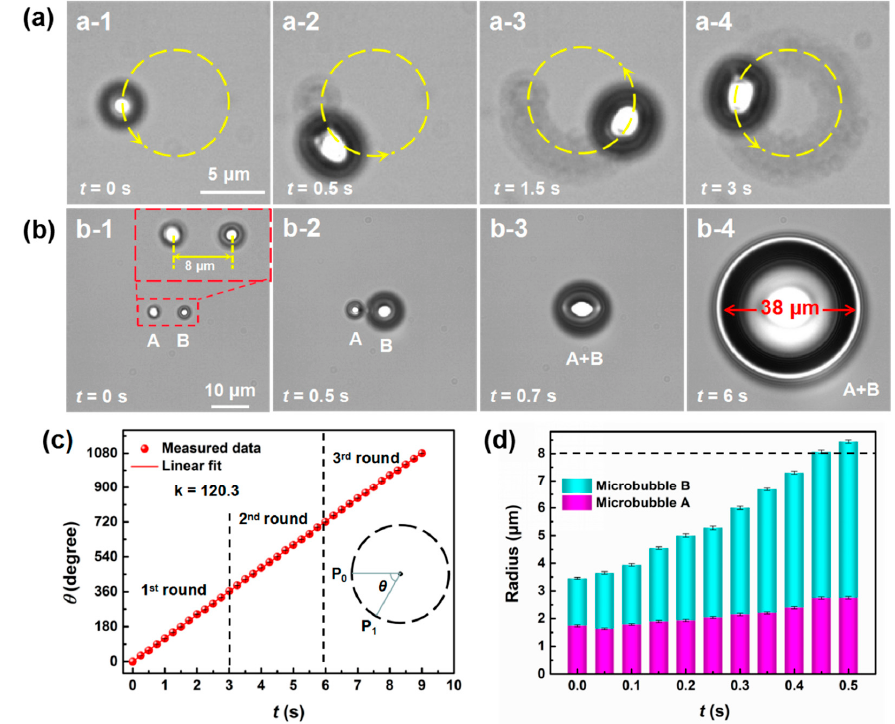
Figure 5. Optical manipulation and fusion of microbubbles. ( a ) Circular movement of a microbubble around a circle with a diameter of 10 µ m. ( b ) Fusion process of two adjacent microbubbles. ( c ) Dependence of the travelled angle of the moving microbubble on time. ( d ) Changes of the radius of microbubble A and B during the fusion process.